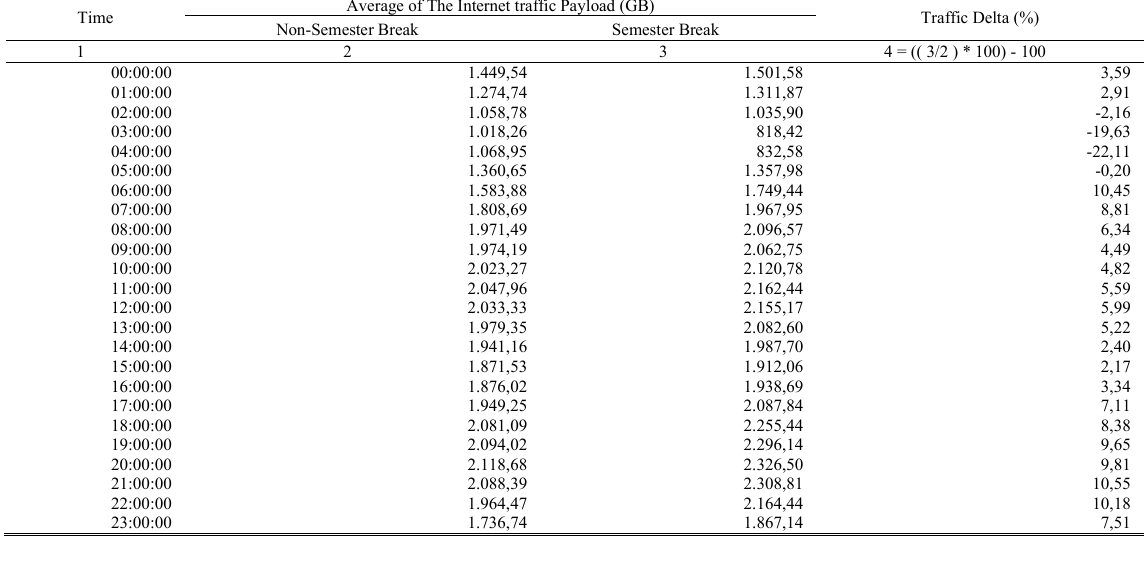
TABLE 4 A VERAGE OF T HE I NTERNET T RAFFIC P AYLOAD AT S EMESTER B REAK AND N ON -S EMESTER B REAK